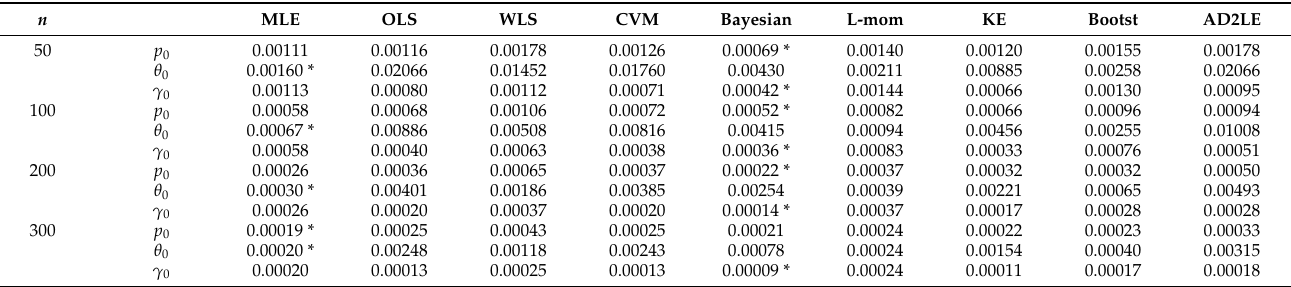
Table 4. Results of the MSEs where p = 0.1, γ = 0.2, θ = 0.9.